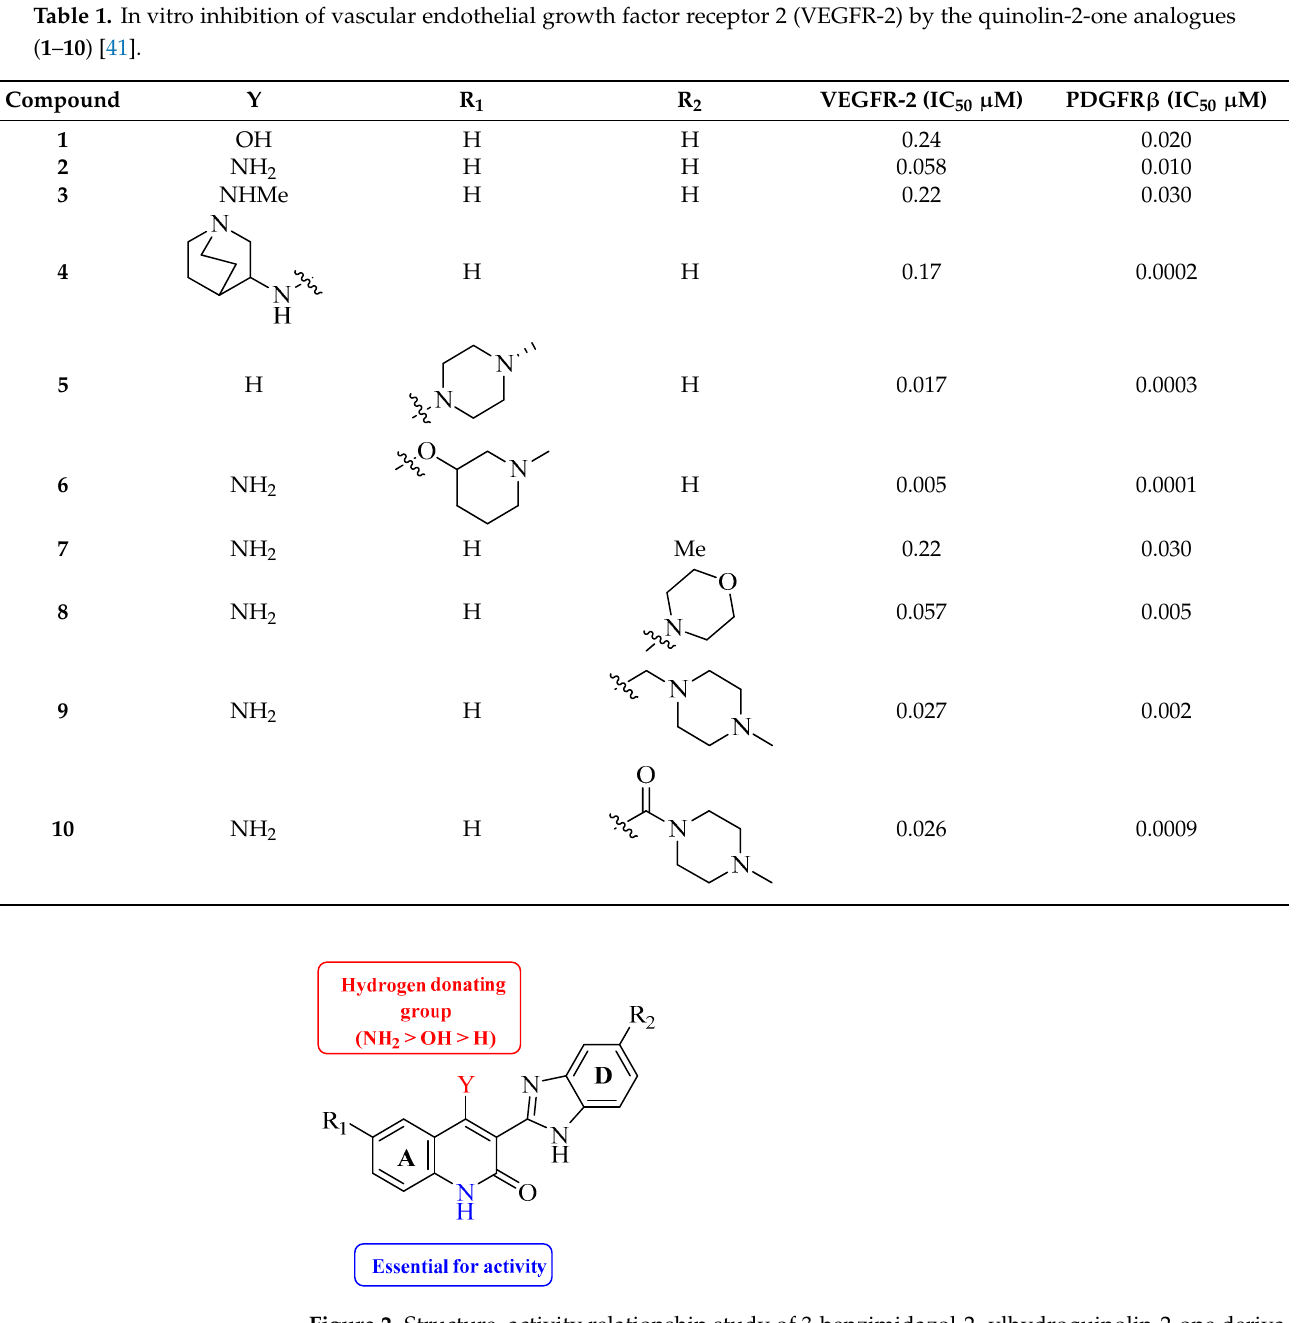
Figure 3. Predicted interaction of compound 10 (imidazole-scaffold) with active site residues of VEGFR-2. ( a ) 3D structural view of ligand inside the receptor’s active site. ( b ) Ligand interaction diagram; violet lines represent hydrogen bonds and red lines represent π –cation interactions. Although VEGF is an important pathway in angiogenesis, several other targets are also involved in angiogenesis. Matrix metalloproteinases (MMPs) are one such target in- volved in angiogenesis [44]. MMPs are implicated in early steps of tumor evolution in- cluding stimulation of cell proliferation and modulation of angiogenesis [45]. During an- giogenesis, new vessels develop from present endothelial lined vessels to encourage the degradation of the vascular basement membrane and remodel the extracellular matrix (ECM), followed by endothelial cell migration, proliferation, and formation of the new generation of matrix components [46,47]. Matrix metalloproteinases participate in the disruption, tumor neovascularization, and successive metastasis, while tissue inhibitors of metalloproteinases (TIMPs) down- regulate the activity of these MMPs [48]. Therefore, MMPs, through the modulation of the balance between pro- and anti-angiogenic factors, can directly or indirectly mediate the angiogenic response [49]. The relation between MMP overexpression in tumor and cancer progression has en- couraged the progress of preclinical trials with a series of inhibitors designed to block the proteolytic activity of these enzymes. Thus far, no FDA-approved MMP inhibitors for the treatment of cancer have emerged. However, several leads have been developed; for example, Becker et al. reported